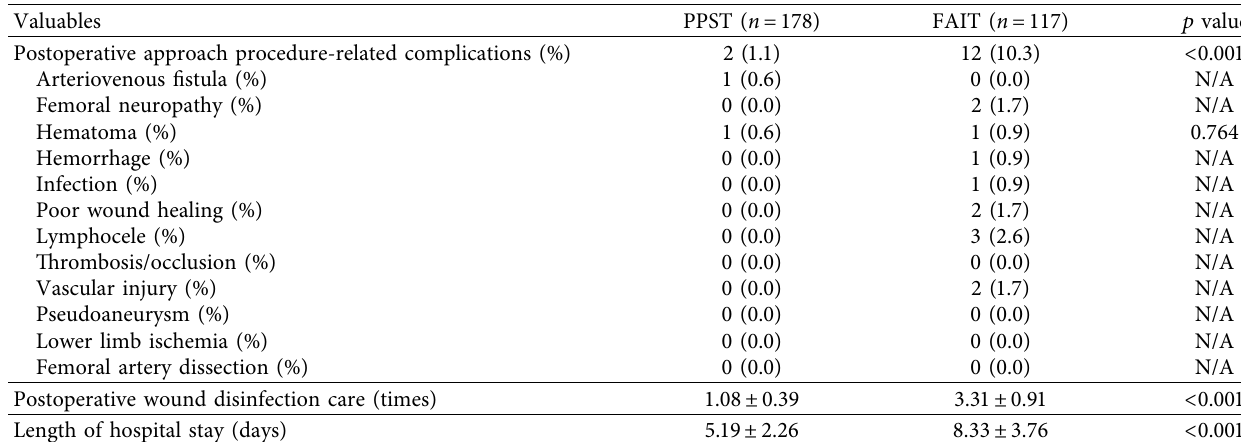
Table 3: Postoperative data on the two patient